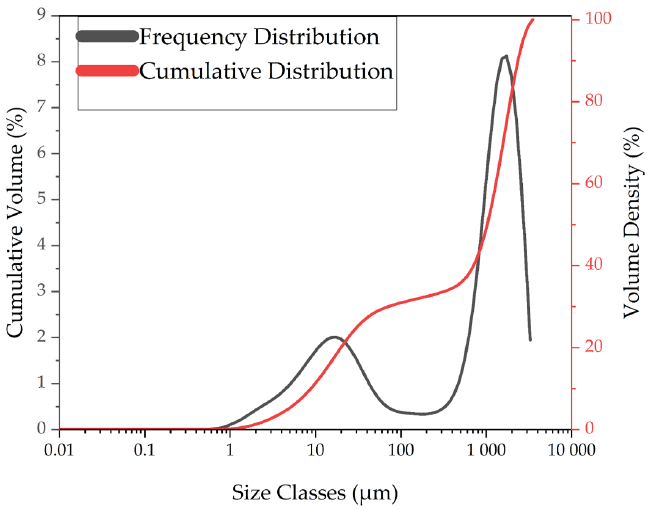
Figure 6. Frequency distribution and cumulative distribution of the sieved LIB waste used as flotation feed.